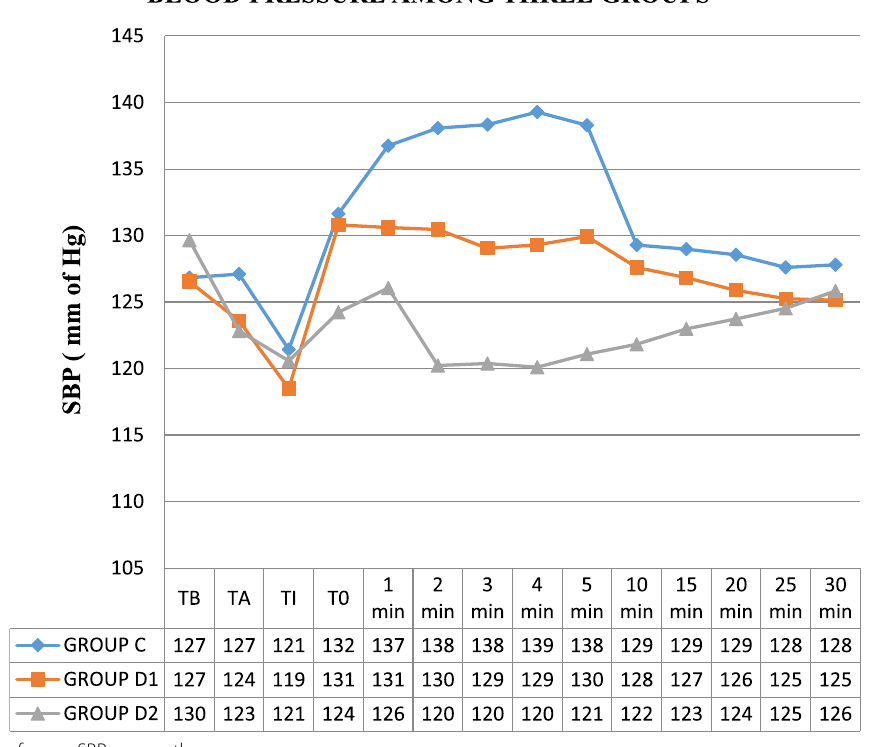
Fig. 3 Comparison of mean SBP among three groups